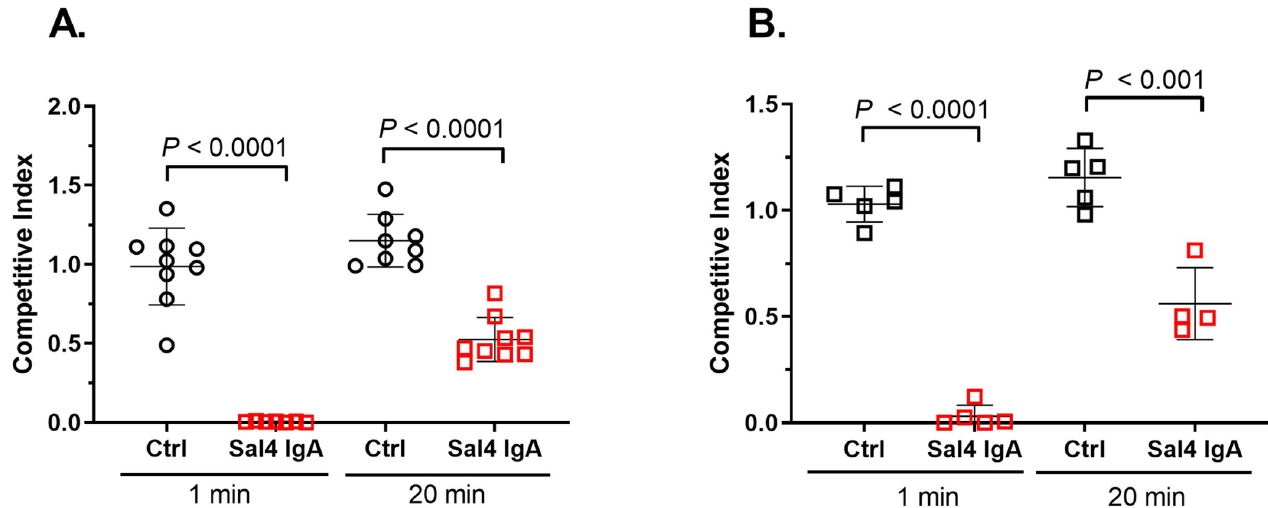
Fig 3. Sodium bicarbonate and protease inhibitors improve Sal4 IgA prophylactic activity. Adult BALB/c mice were gavaged with Sal4 IgA (50 μ g) in (A) 3% NaHCO 3 or (B) a protease inhibitor cocktail 20 min or 1 min before STm challenge. The mice were euthanized 24 h later and Peyer’s patches were assessed for bacterial loads, as a readout of bacterial invasion. Shown are the results of three independent experiments with at least 5 mice per group. Each symbol represents an individual mouse. Statistical significance compared to the isotype control at each time point, as determined by unpaired Student’s t -test.